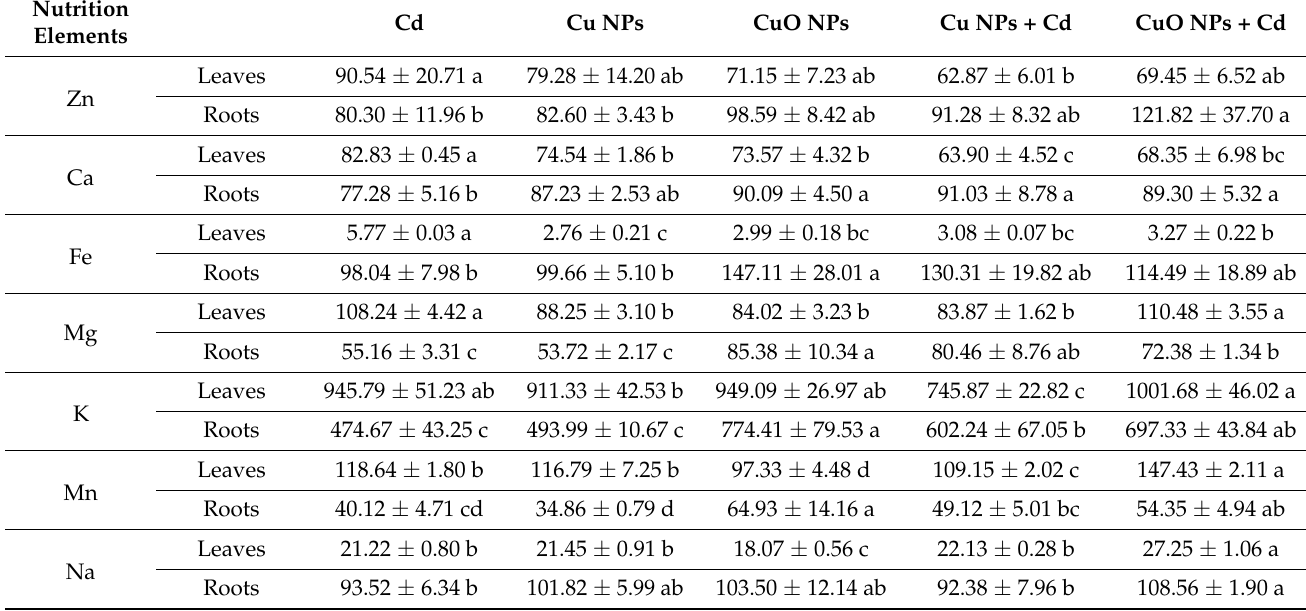
Table 2. Effects of Cu NPs, CuO NPs and Cd on nutrient content. The mean is the mean of three replicates and the error bars correspond to the standard deviation of the three values. Different letters above each column indicate significant differences among treatments in the same group ( p <